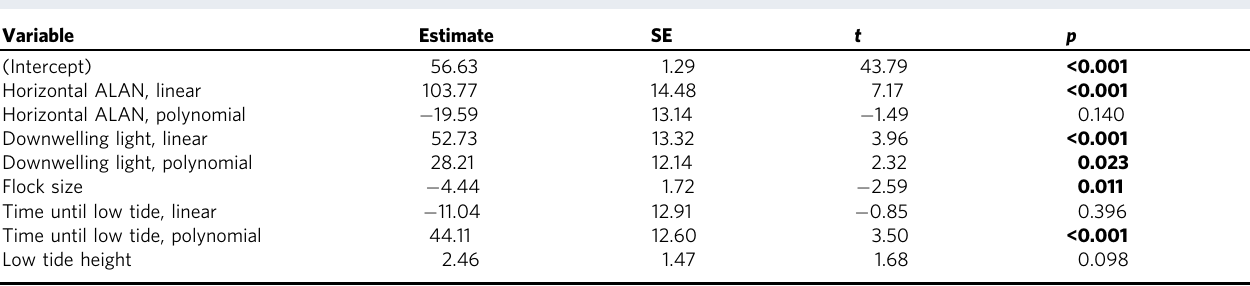
Bold values indicate statistical signi fi cance p <0.05. Horizontal ALAN, downwelling light (linear and second-order polynomial), fl ock size and time until low tide were the signi fi cant predictors of the FID in the best, simpli fi ed